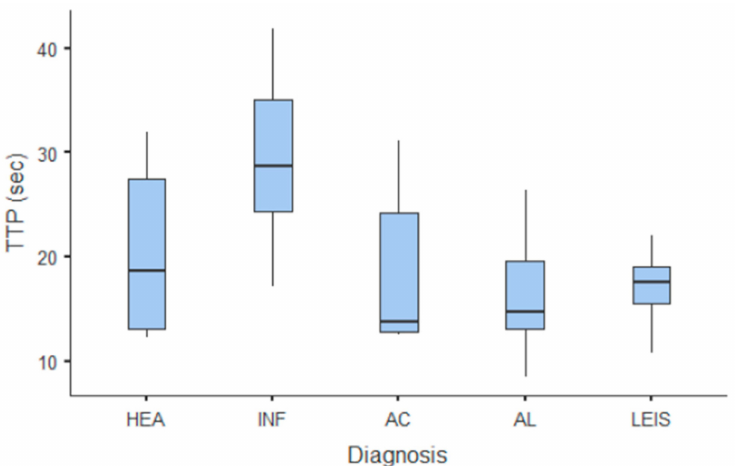
Figure 5. Box and whisker plot of the time to peak (TTP) for healthy (HEA), inflammatory (INF), adenocarcinoma (AC), lymphoma (AL), and leiomyosarcoma (LEIS).